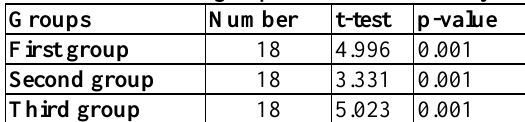
Table 5: Independent sample t-test to compare the value of ∆ E difference between middle and gingival third for the three groups included in this